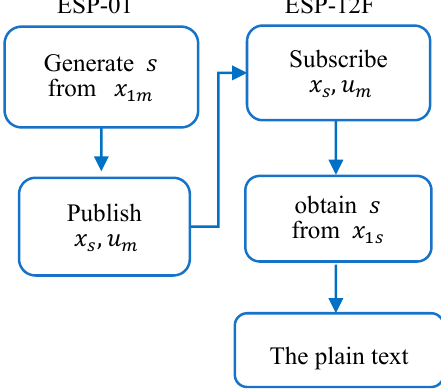
Figure 6. Non-synchronization Chaos Synchronization Attribution-Based Encryption Scheme (CS-ABE) flow chart.